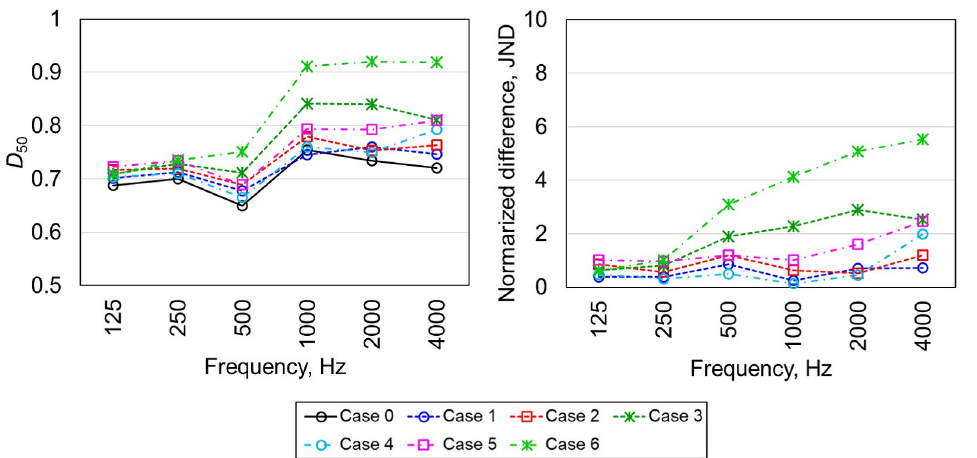
Figure 12. Spatially averaged D 50 s in a small meeting room for cases 0–6 ( Left ) and differences from case 0 normalized by JND value (5% [29]) ( Right